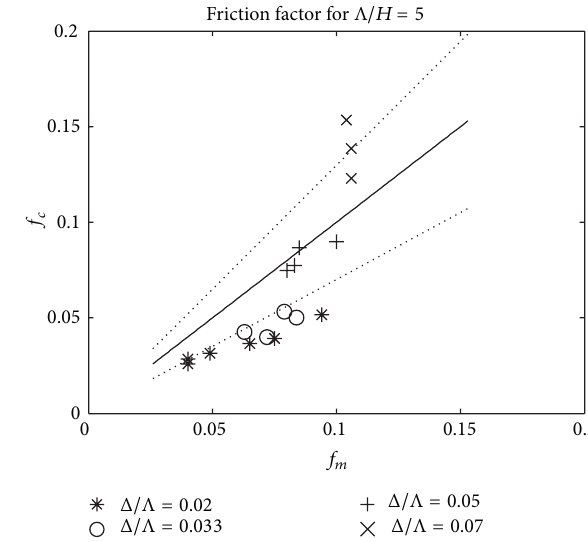
Figure 2: Comparison between measured [9] and calculated fric- tion factors. The dotted lines correspond to the 70% confidence interval.